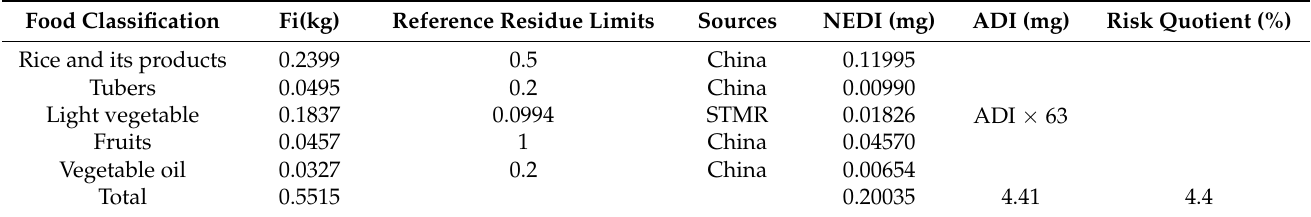
Table 5. Chronic dietary risk assessment of flonicamid based on Chinese dietary